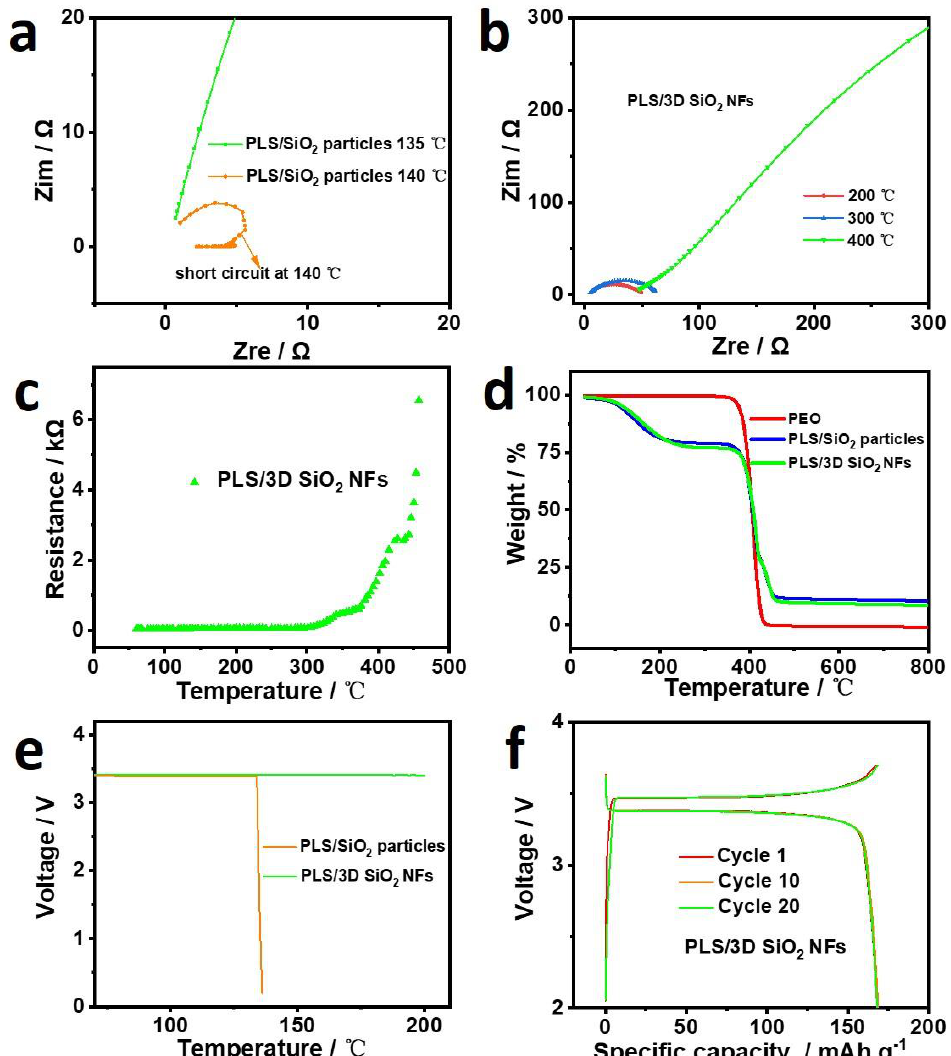
Figure 7. ( a ) AC impedance curves of PLS/SiO 2 particles at 135 and 140 °C . AC impedance curves ( b ) and resistance ( c ) of PLS/3D SiO 2 NFs at 200–400 °C . ( d ) TGA profiles of PEO, PLS/SiO 2 particles, and PLS/3D SiO 2 NFs with a heating rate of 10 °C min −1 . ( e ) Open circuit voltage (OCV) of Li | PLS/SiO 2 particles | LFP and Li | PLS/3D SiO 2 NFs | LFP pouch cells as a function of temperature at 60 – 200 °C . ( f ) Charge and discharge curves of Li | PLS/3D SiO 2 NFs | LFP pouch cells after OCV treatment. The OCVs of Li | PLS/SiO 2 particles | LFP and Li | PLS/3D SiO 2 NFs | LFP pouch cells as a